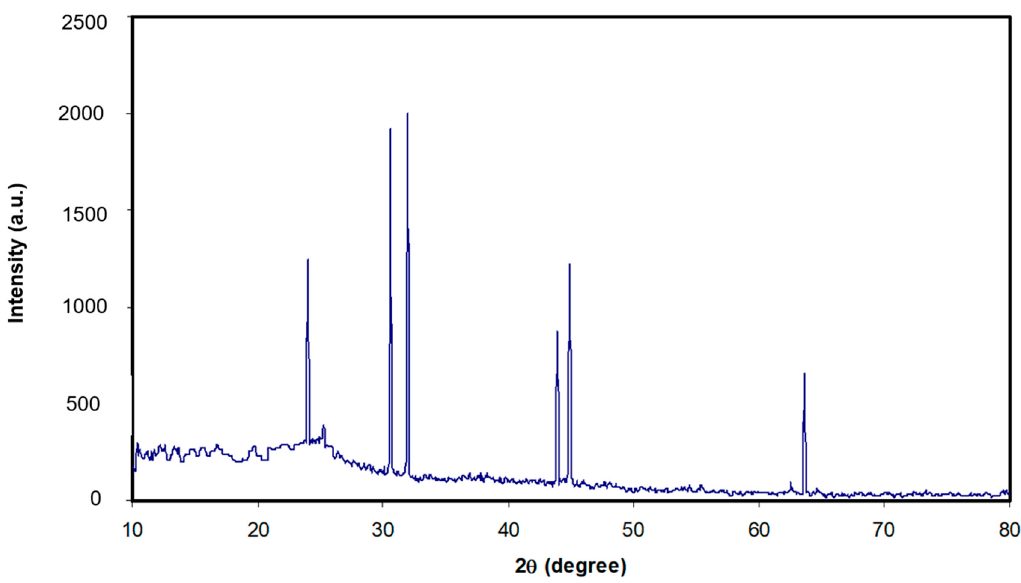
Figure 1. X-ray diffraction pattern for a—pure PS (PSSNT0), b—PSSNT1, and c—PSSNT2 nanocomposite films.